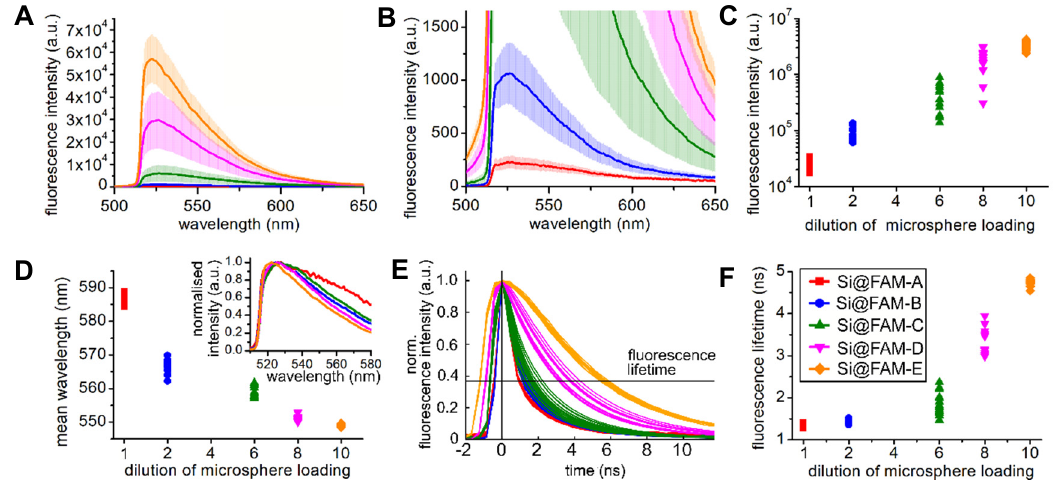
Figure 2. Changes in the fluorescence emission with varying fluorophore loadings on the beads. The loading solution of Si@FAM-E was 10× diluted compared to that of Si@FAM-A. All measurements aretaken at pH 7.2. The legend for all figures is placed in ( F ): ( A ) The fluorescence spectra. The line is the mean of the intensities from the cores, the standard deviation is shown as shaded area. ( B) For visibility, the same data is expanded to illustrate the lower fluorescence intensity signals. ( C – F ) show the data from all beads on each plot. ( C ) Fluorescence intensity (log scale) calculated as the area under the curve of the fluorescence spectra. ( D ) Mean wavelength of the fluorescence spectra line shape (inset shows the normalised mean spectra). ( E ) Normalised fluorescence decays from the data summed across the 520 to 700 nm spectral range. ( F ) Fluorescence lifetime, derived from the decays in ( E ) via an exponential fitting routine.